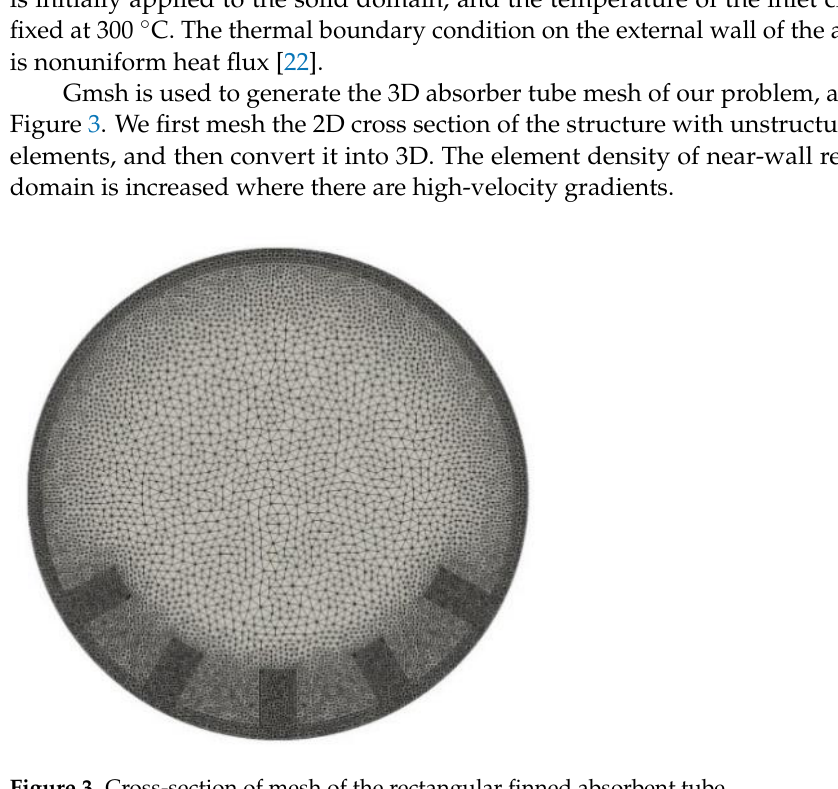
Figure 3. Cross-section of mesh of the rectangular finned absorbent tube. The mesh independence tests are shown in Table 2, which are carried out for average temperature of the outlet cross section and average pressure of the inlet cross section of three sizes of grids. For all the cases, the temperature and pressure deviations are no adopted to handle the simulation calculations. Table 2. Mesh independence tests.